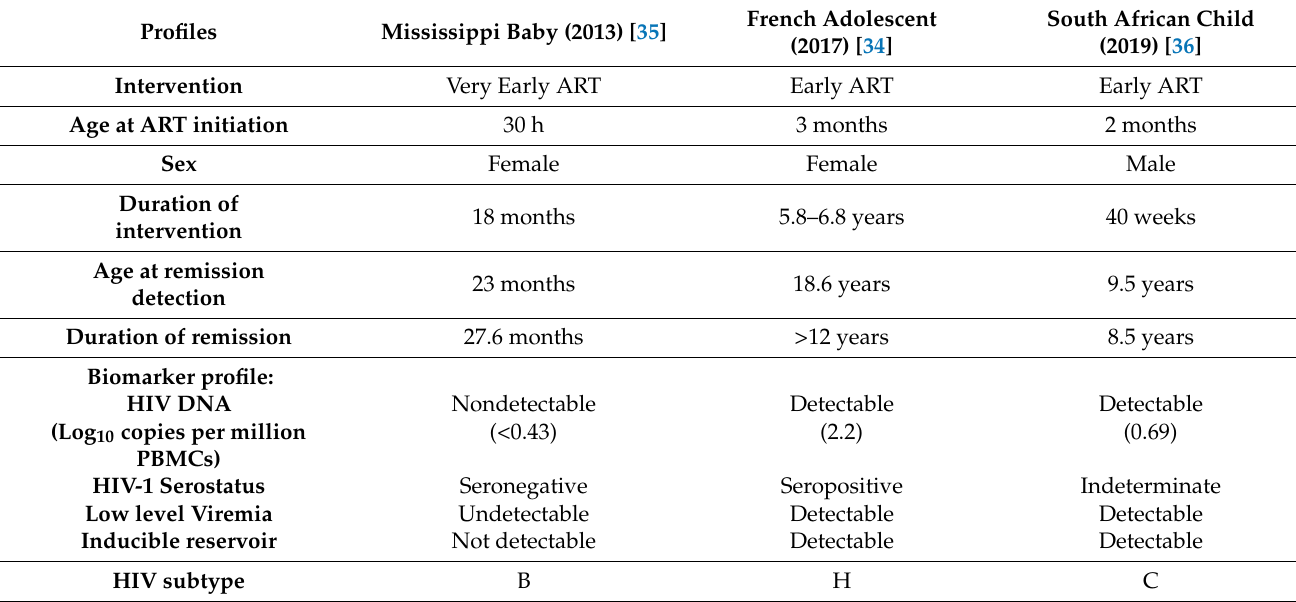
Table 2. Comparison of the three cases of ART-free remission in perinatal